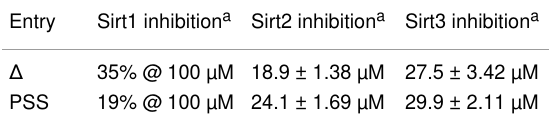
Table 3: Sirt1-3 inhibition for compound 11 at the thermal equilibrium ( ∆ ) and the photostationary state (PSS) after 5 minutes of 365 nm irra-